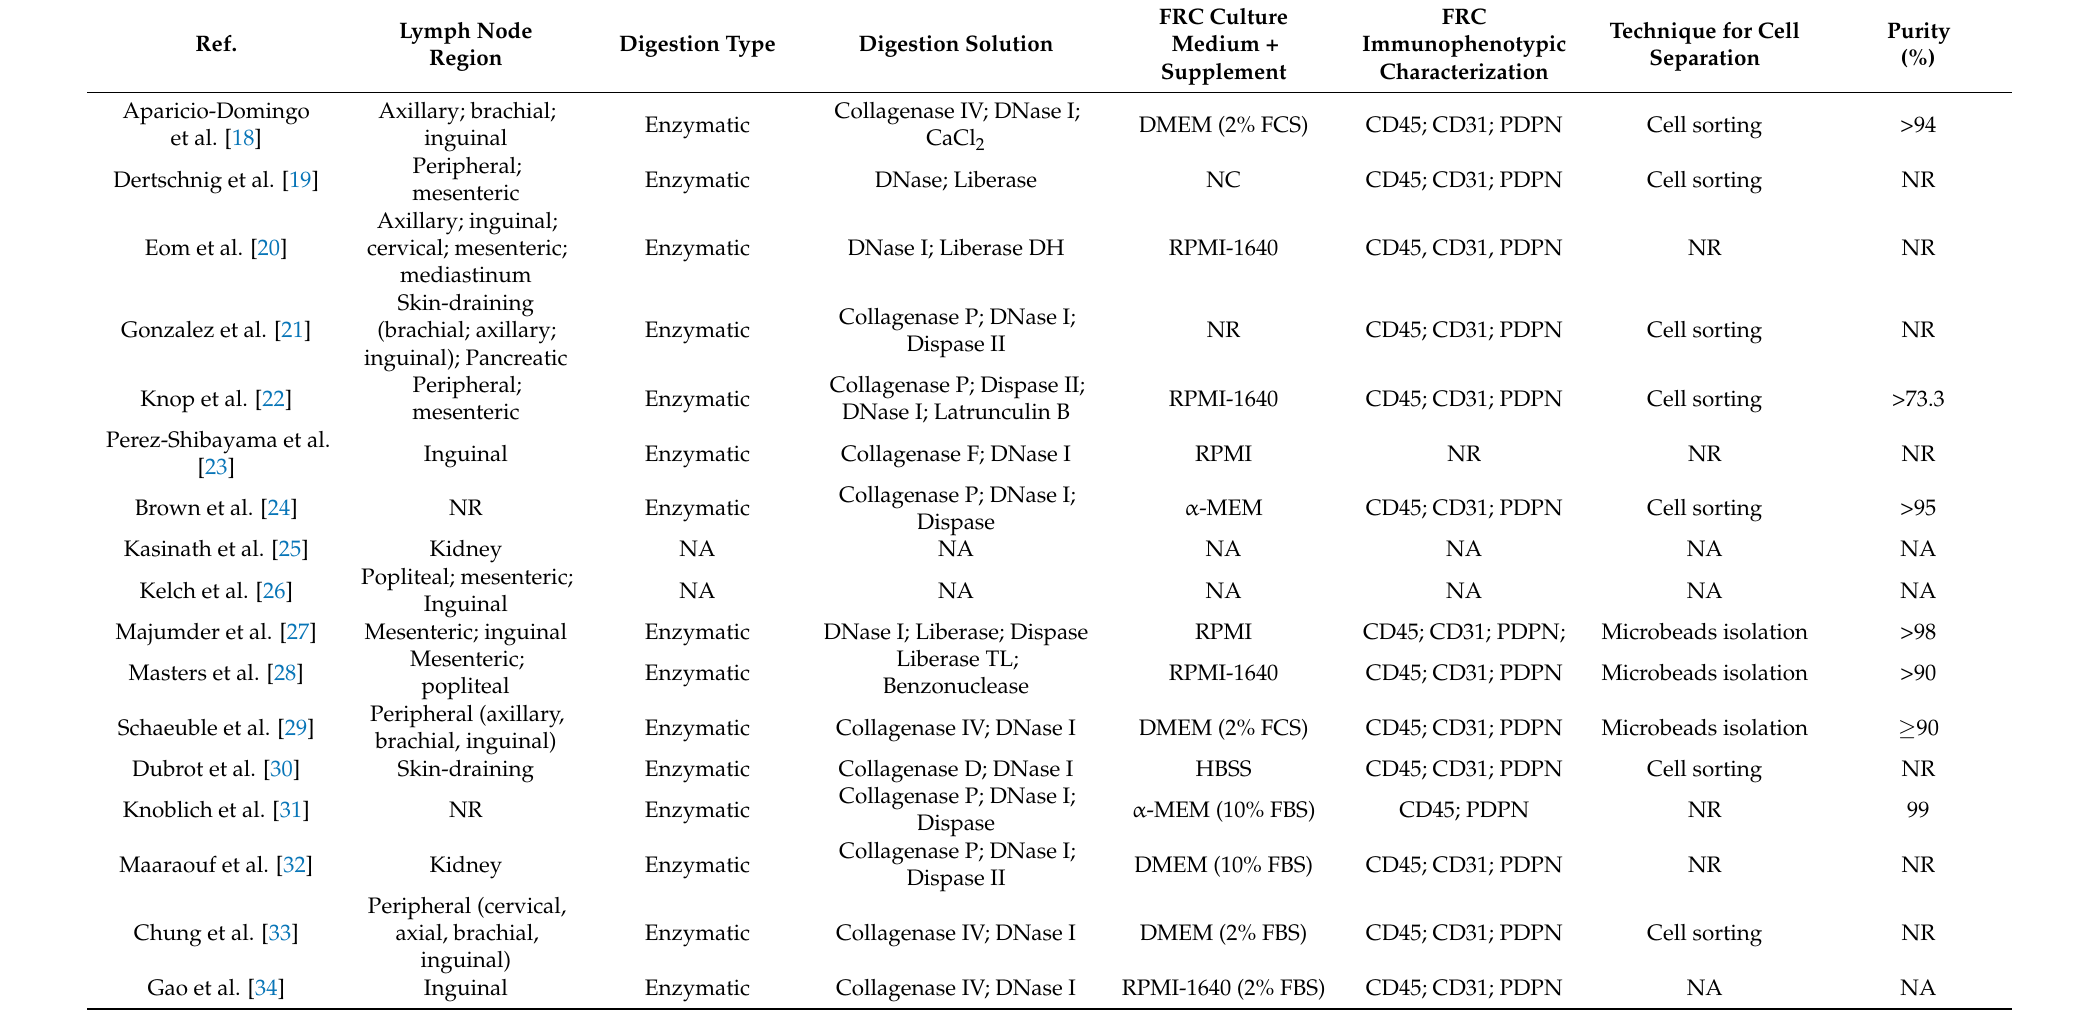
Table 2. Characteristics of fibroblastic reticular cells isolation and their